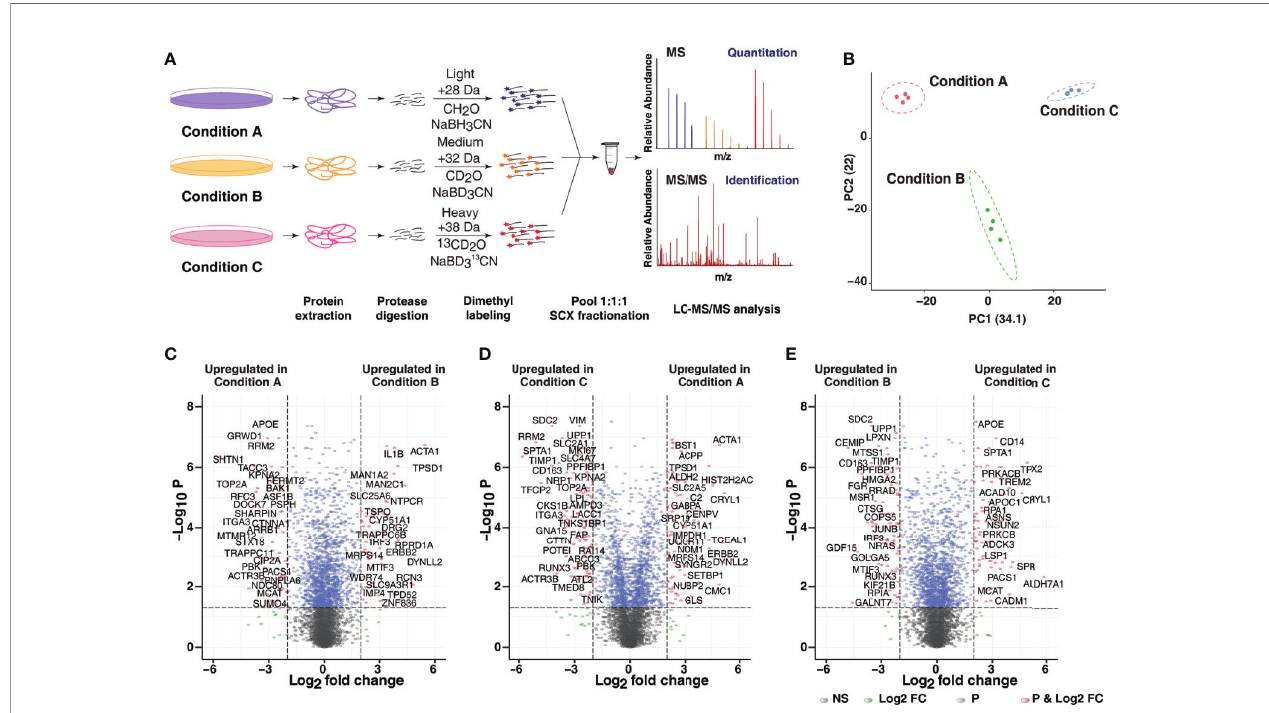
FIGURE 2 | Quantitative proteomic analysis of PMA-induced changes. (A) The experimental strategy employed for comparative proteome analysis in response to varying PMA-mediated differentiation protocols. Dimethyl labeling-based quantitative proteomic approach was employed to identify and quantify the proteome changes in Condition A (Light), Condition B (Medium), and Condition C (Heavy). The data were acquired in biological quadruplicates, and only proteins identi fi ed and quanti fi ed in all 4 replicates were considered for further analysis. (B) Principal component analysis (PCA) reveals that the three treatment conditions for monocyte-to macrophage differentiation of THP-1 cells segregate from each other on the basis of concentration and duration of PMA treatment. All replicates of a given condition cluster together, suggesting minimal biological variability. (C – E) Volcano plot displaying differential expressed proteins between (C) Condition A vs. B (D) Condition C vs. A and (E) Condition C vs. B. The vertical axis (y-axis) corresponds to the mean expression value of log 10 (p-value), and the horizontal axis (x-axis) displays the log2-fold change value. The red dots represent overexpressed proteins, and the green dots represent proteins with downregulated expression. Positive x-values represent overexpression, and negative x-values represent